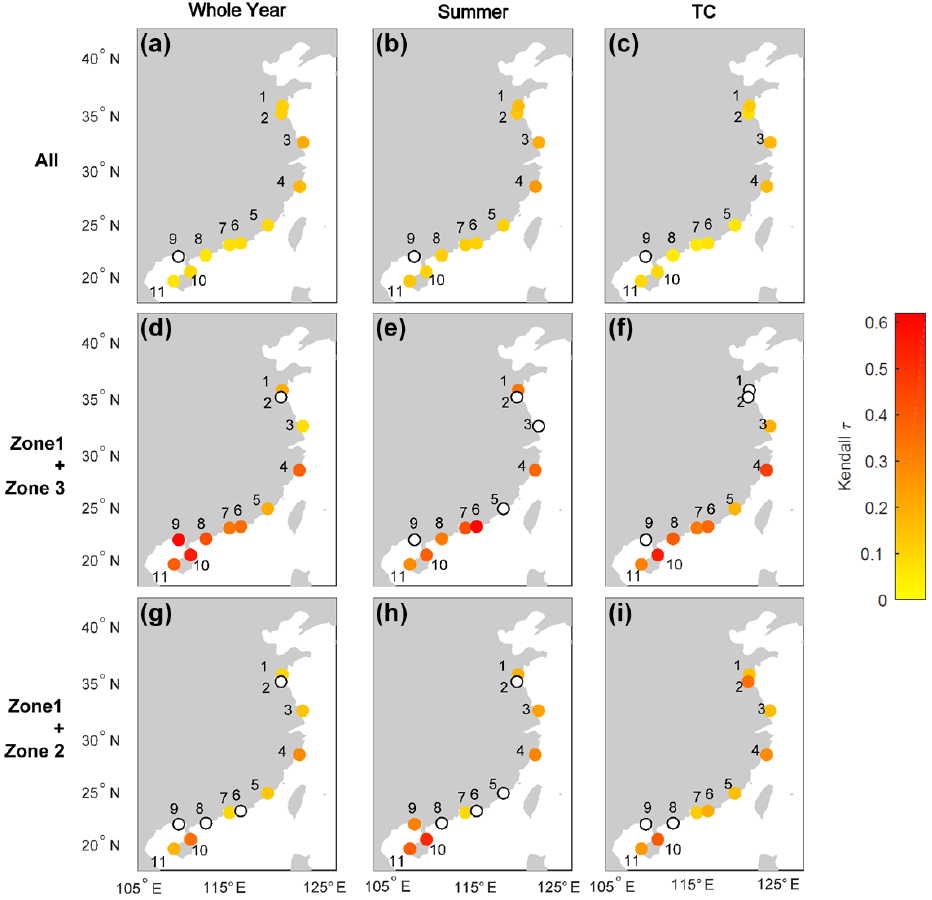
Figure 4. Kendall dependence between storm surge and precipitation in summer, the TC season, and the whole year. (a–c) Daily maximum storm surge and daily cumulative precipitation, (d–f) pairs in Zone 1 + Zone 3, and (g–i) pairs in Zone 1 + Zone 2; maximum dependence for thresholds running from 95% to 99.5% is shown. White dots refer to insignificant dependence (10%